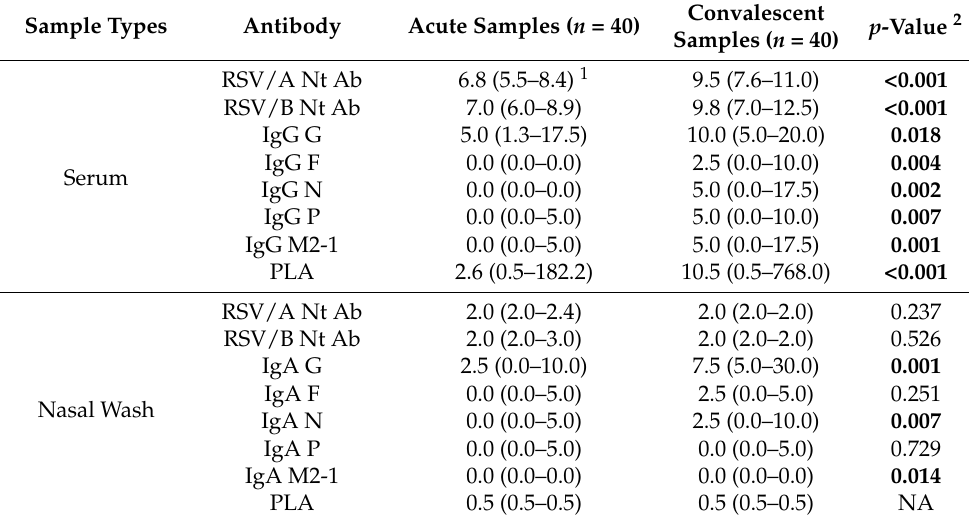
Table 1. Comparison of Humoral and Mucosal RSV Antibody Level in Acute and Convalescent